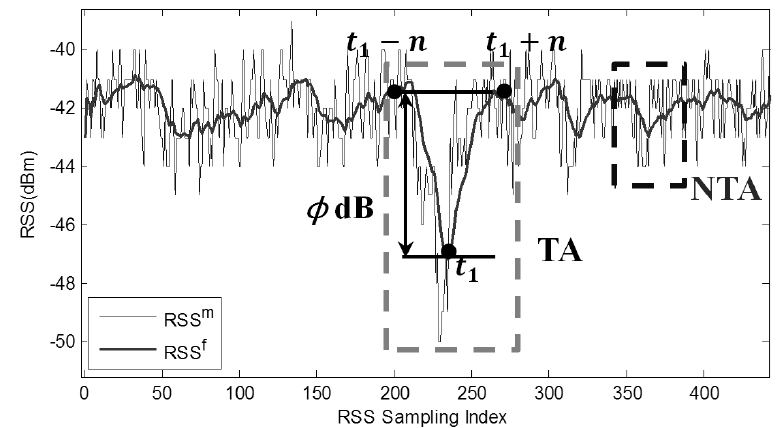
Figure 2. Received signal strength (RSS) measurement when a pedestrian passes through the line-of-sight (LOSL) at time index 𝑡 .